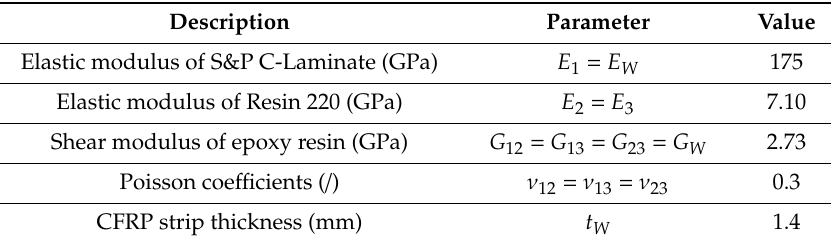
Table 4. Average properties of CFRP tapes according to References